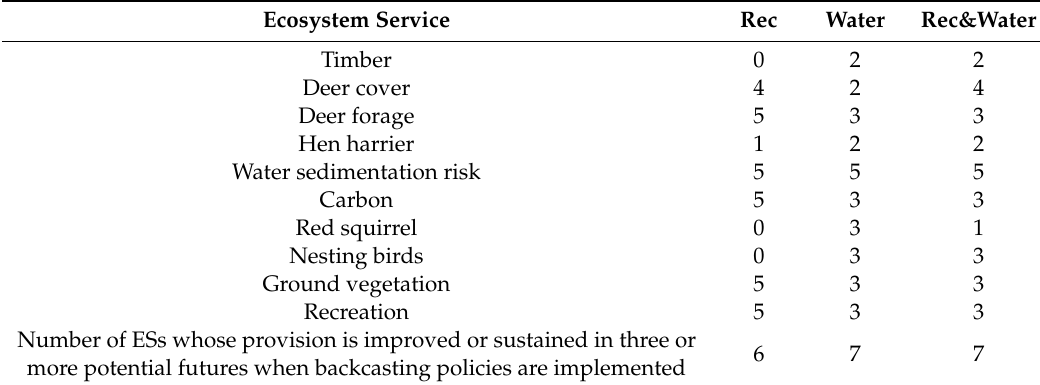
Table 15. The number of PFs (out of a maximum of five) where the average ES level (presented in Table 12) stays the same or moves towards the stakeholders’ desired ES level through the implementation of the backcasting policies in the WP CSA.